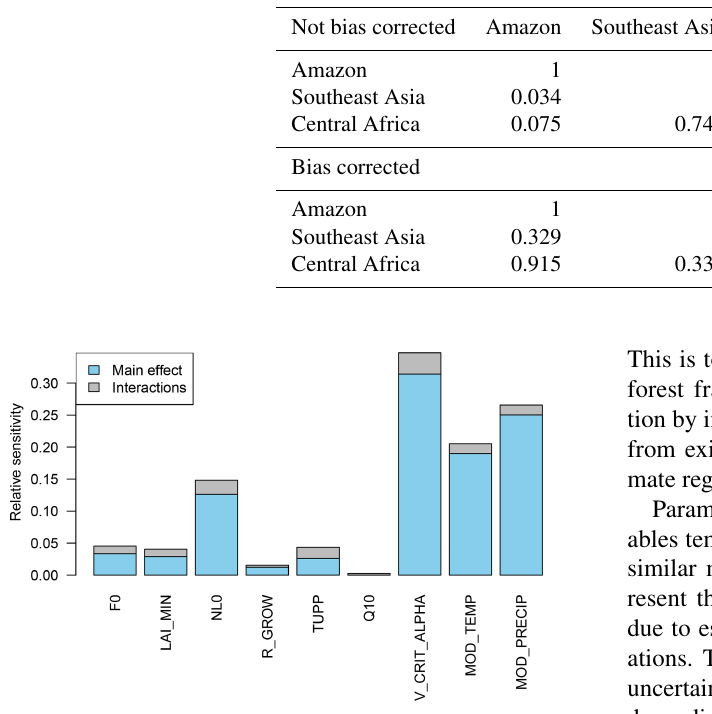
Figure 13. Sensitivity of forest fraction to model parameters and climate parameters, found using the FAST99 algorithm of Saltelli et al.